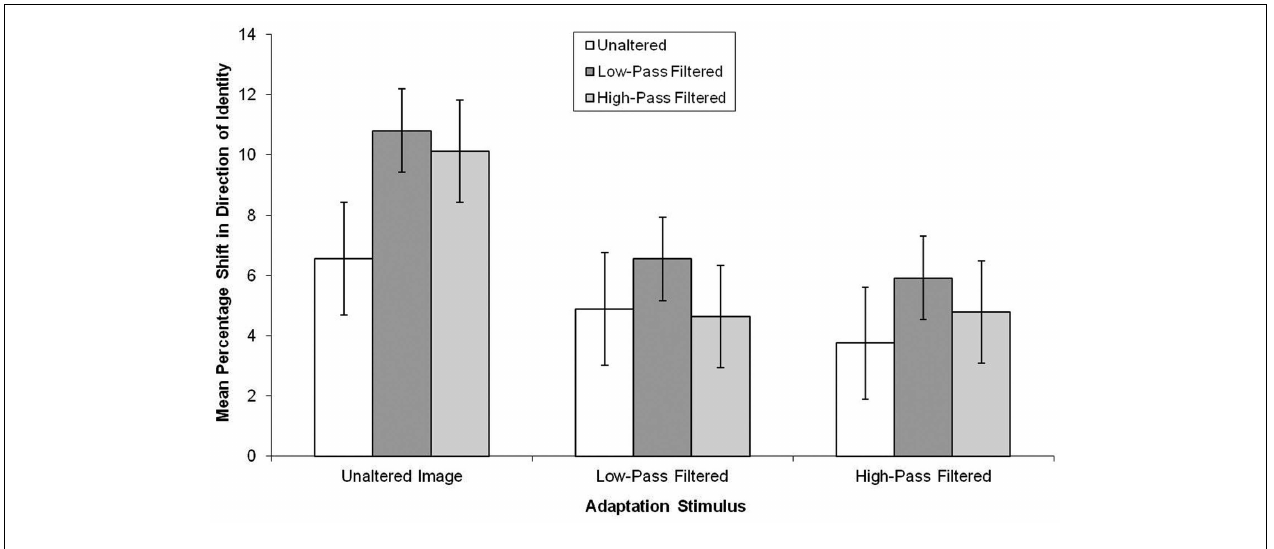
FIGURE 6 | Mean PSE (in identity strength needed to perceive the adapted identity) shift pre- to post-adaptation (as a measure of the magnitude of the aftereffect), for unaltered, low-pass, and high-pass